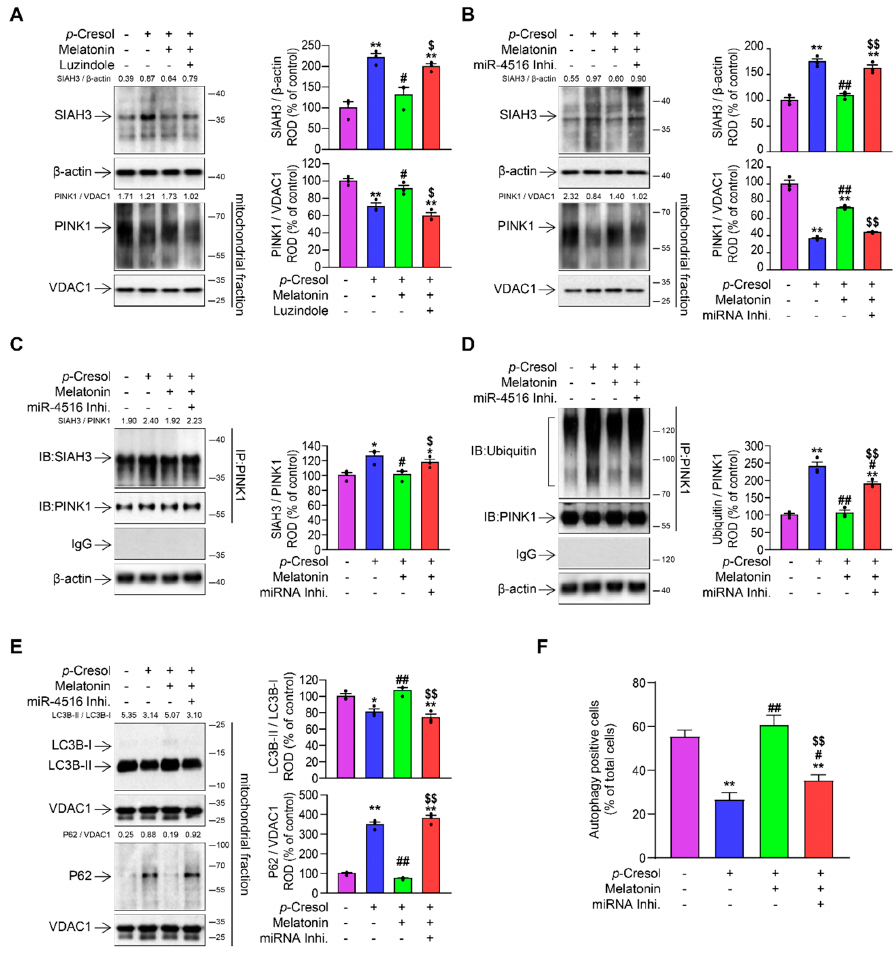
Figure 2. Melatonin-induced miR-4516 promotes PINK1/Parkin-mediated mitophagy by suppressing SIAH3. ( A ) Expres- sion of SIAH3 and PINK1 in melatonin-treated TH1 cells (1 μ M for 24 h) or pretreated with the luzindole (1 μ M for 48 h) under p -Cresol exposure (0.5 mM for 72 h) (n = 3). Protein expression level was quantified by densitometry and normalized to β -actin or VDAC1 levels (n = 3). ( B ) Expression of SIAH3 and PINK1 in melatonin-treated TH1 cells (1 μ M for 24 h) or pretreated with the miR-4516 inhibitor (50 nM for 48 h) under p -Cresol exposure (0.5 mM for 72 h) (n = 3). Protein expres- sion level was quantified by densitometry and normalized to β -actin or VDAC1 levels (n = 3). ( C ) After immunoprecipita- tion against PINK1, the precipitates were analyzed by immunoblotting with SIAH3 antibody. Proteins signals were quan- tified by densitometry and were normalized to PINK1 levels (n = 3). ( D ) PINK1 immunoprecipitates were analyzed by immunoblotting with the ubiquitin antibody. ( E ) LC3B-II/LC3B-I ratio and P62 expression level was measured with im- munoblotting. Protein expression was quantified by densitometry and normalized to VDAC1 levels (n = 3). ( F ) The per- centage of autophagy positive cells in melatonin-treated TH1 cells (1 μ M for 24 h) under p -Cresol exposure (0.5 mM for 72 h). TH1 cells were pretreated with the miR-4516 inhibitor (50 nM for 48 h) before melatonin treatment (n = 3). All reported values represent mean ± SEM, * p < 0.01, ** p < 0.01 versus control; # p < 0.05, ## p < 0.01 versus p -Cresol exposure; $ p < 0.05 $$ p < 0.01 versus melatonin-treated cells under p -Cresol exposure. The β -actin or VDAC1 was used as Western blot loading control for whole cell lysates or mitochondrial fraction respectively.